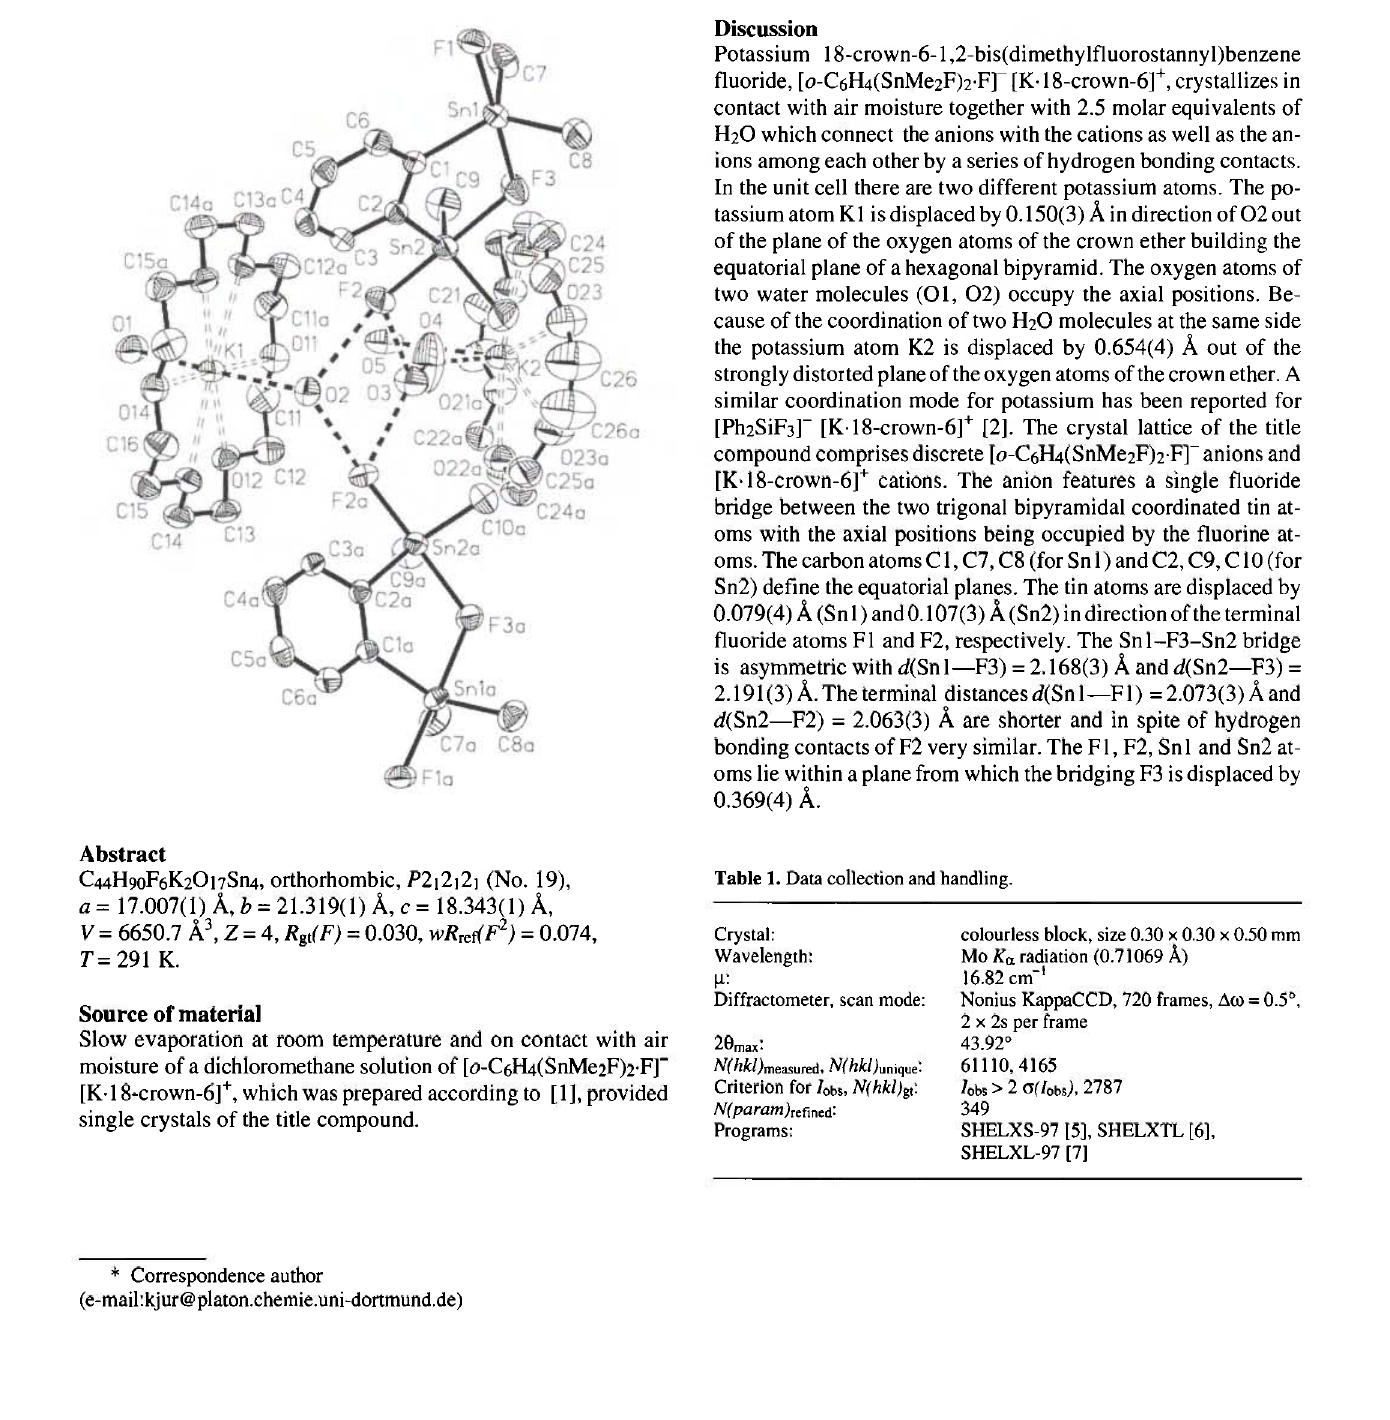
Table 1. Data collection and handling.